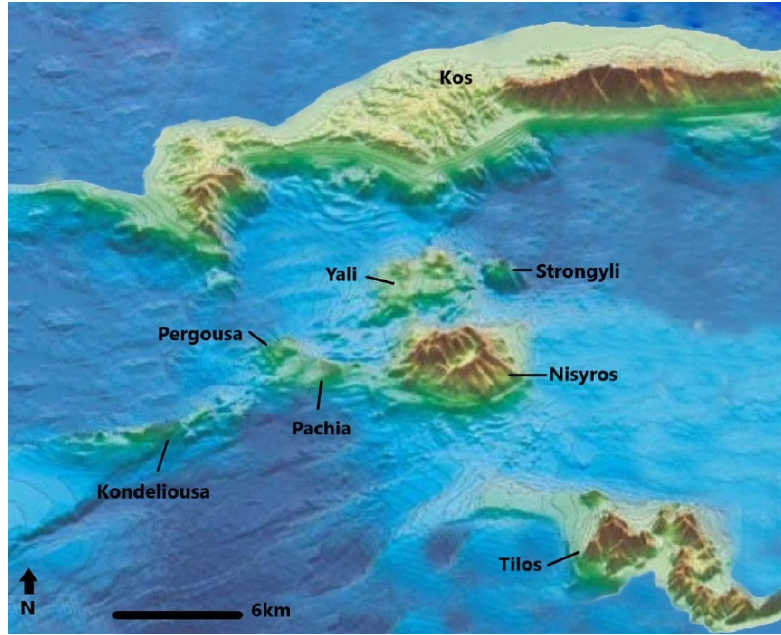
Figure 6. Nisyros and the other smaller island around [63], modified.